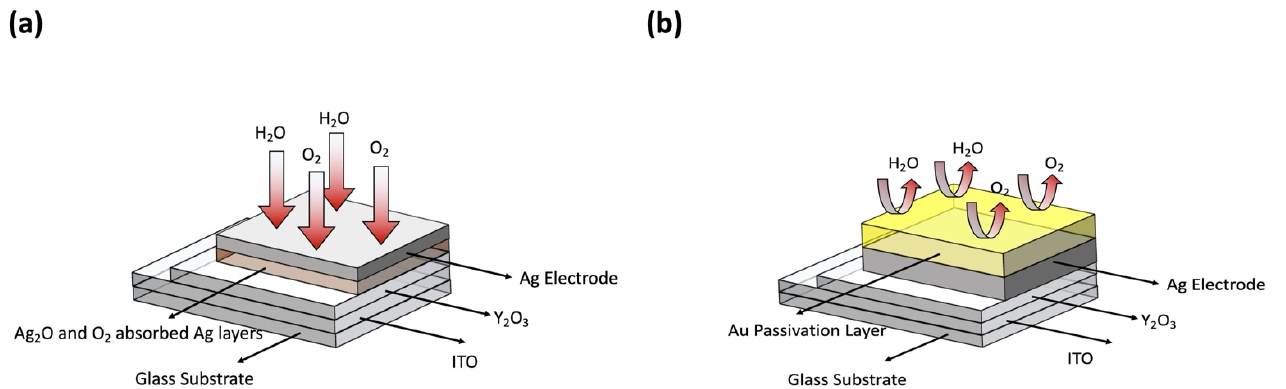
Figure 6. The schematics of the potential mechanism of water or oxygen molecules effects on oxidation of Ag electrodes ( a ) and Au passivation effect ( b ), respectively.